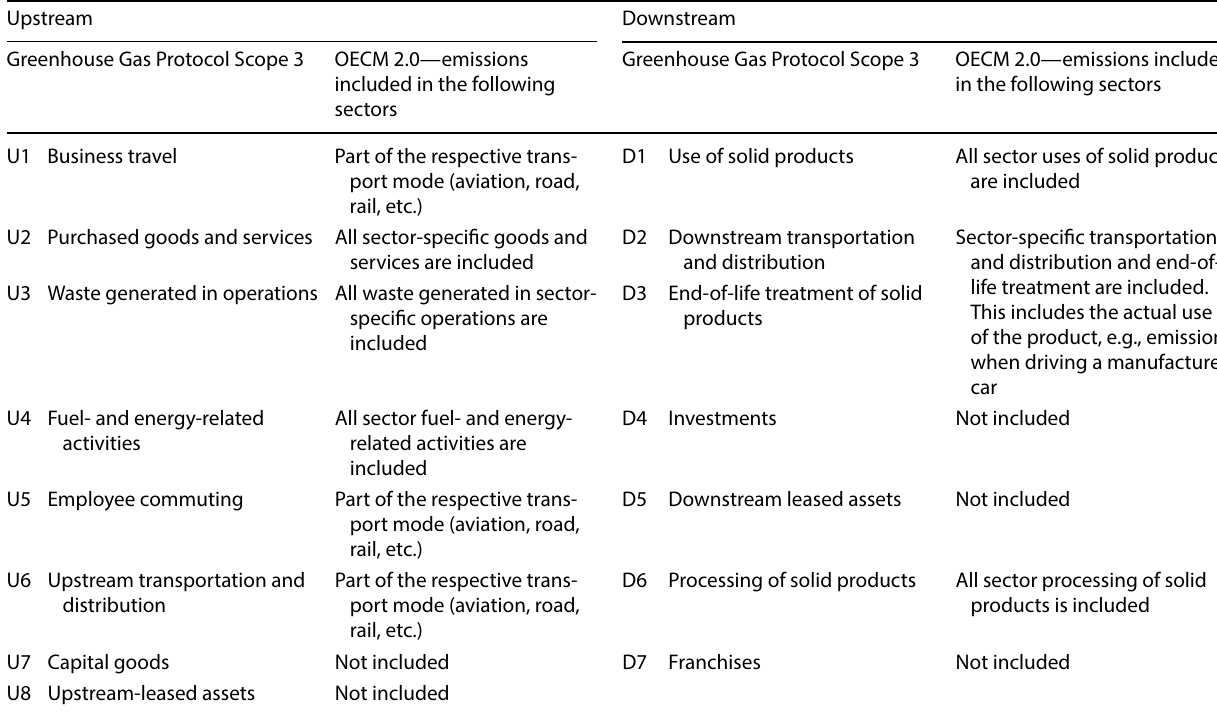
Table 1 Upstream and downstream Scope 3 emissions categories [10, 22]